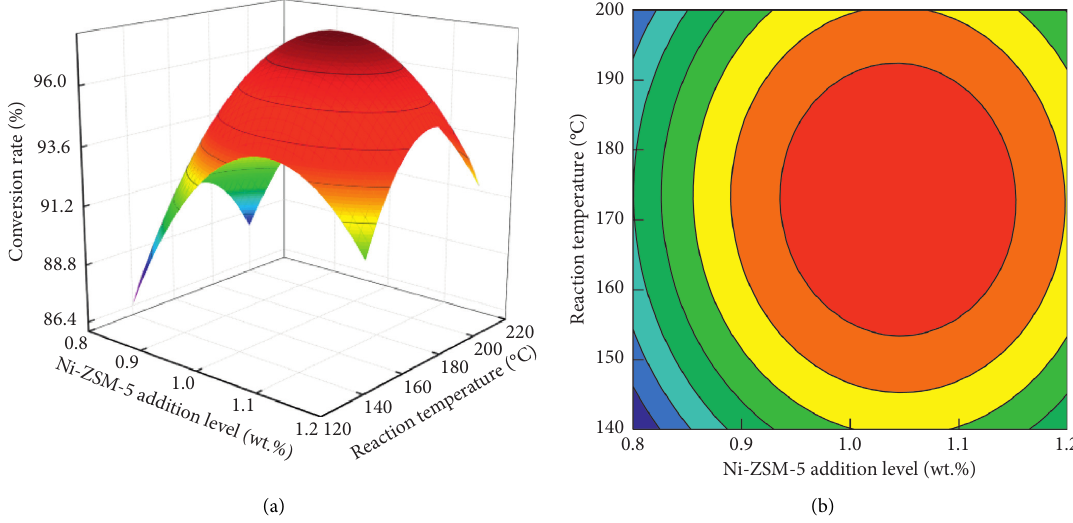
Figure 11: The effect of the Ni-ZSN-5 addition level and reaction temperature on conversion.